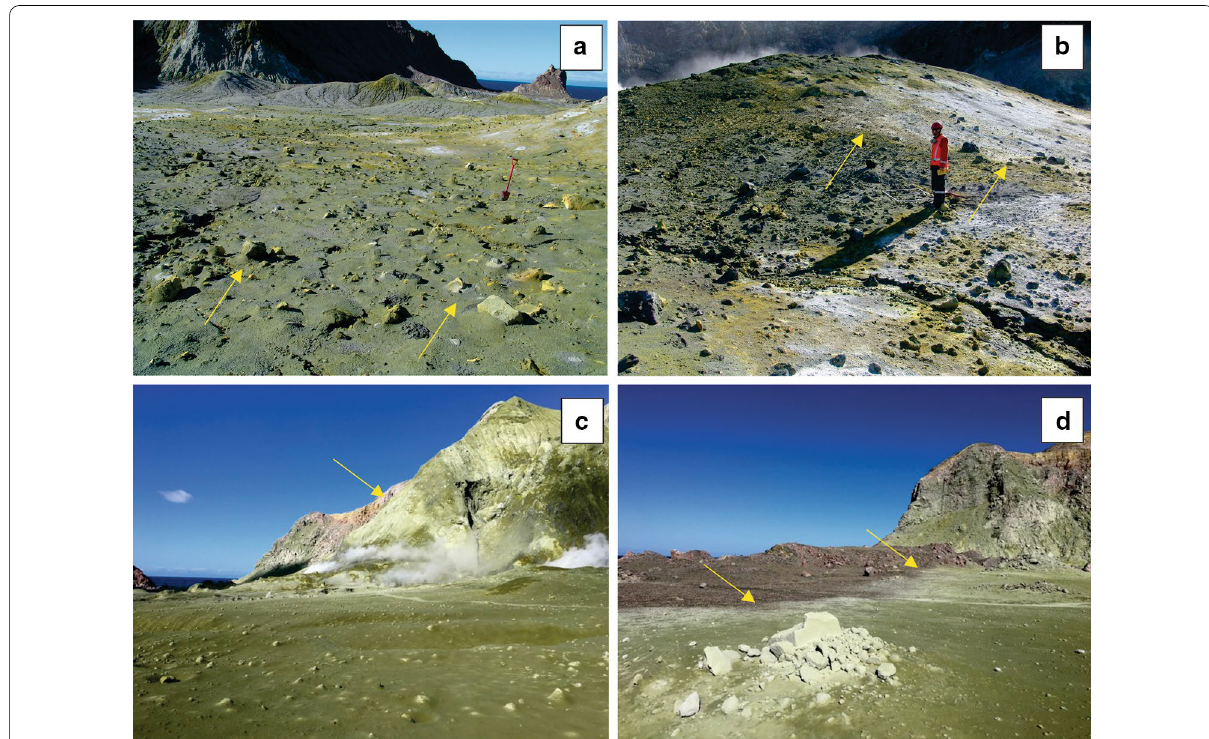
Fig. 6 a Image taken from near the inner crater wall looking to the east. Arrows indicate the preferential burying angle caused by the later parts of the pyroclastic surge partially covering previously ejecta ballistic blocks. b From the same location as in ( a ), looking to the north towards Donald Mound (Fig. 1), a positive topographic feature. Note the sharp ballistic margin (arrow). c Image of the south-eastern area of the crater wall from the centre of the main crater floor. Note the discoloured ash oxidation high up on the crater wall. d The eastern edge of the pyroclastic surge deposit. Note the medium grey-coloured outer margin of the deposit marking current